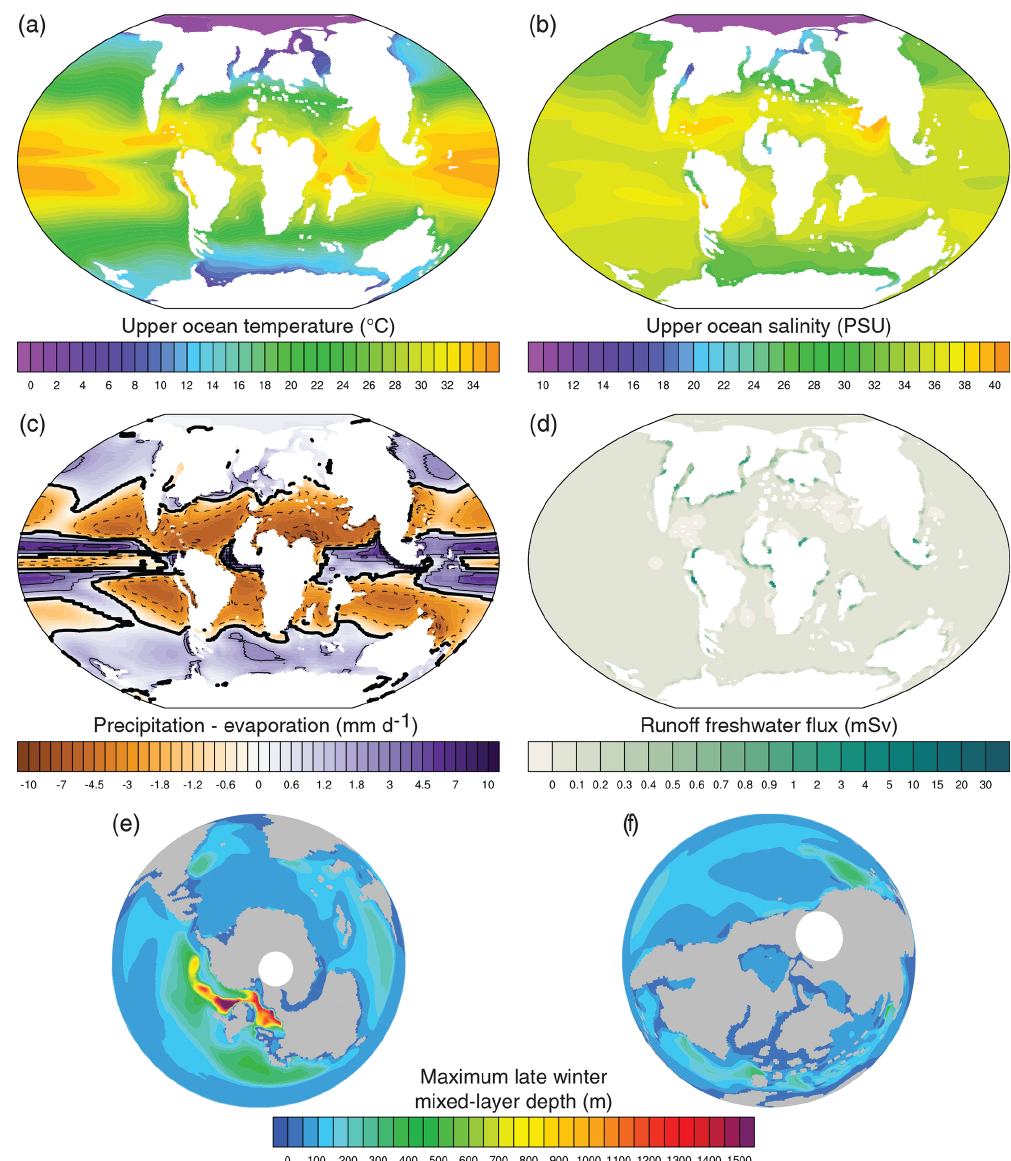
Figure 8. Climate diagnostics for the Maastrichtian simulation. (a) Surface ocean (upper 100m) temperature ( ◦ C). (b) Surface ocean (upper 100m) salinity (PSU). (c) Precipitation minus evaporation (mmd − 1 ). (d) Runoff freshwater flux (mSv). (e, f) Late winter maximal mixed layer depth